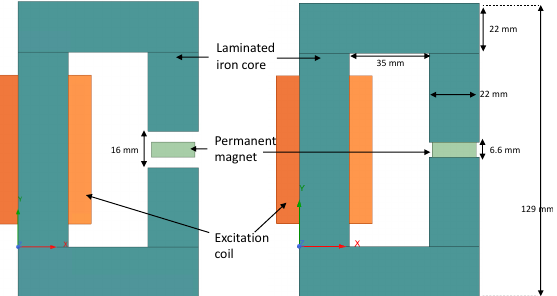
Figure 3. Two-dimensional FEA models: gapped core ( left ) and ungapped core ( right ) to analyze magnet losses.